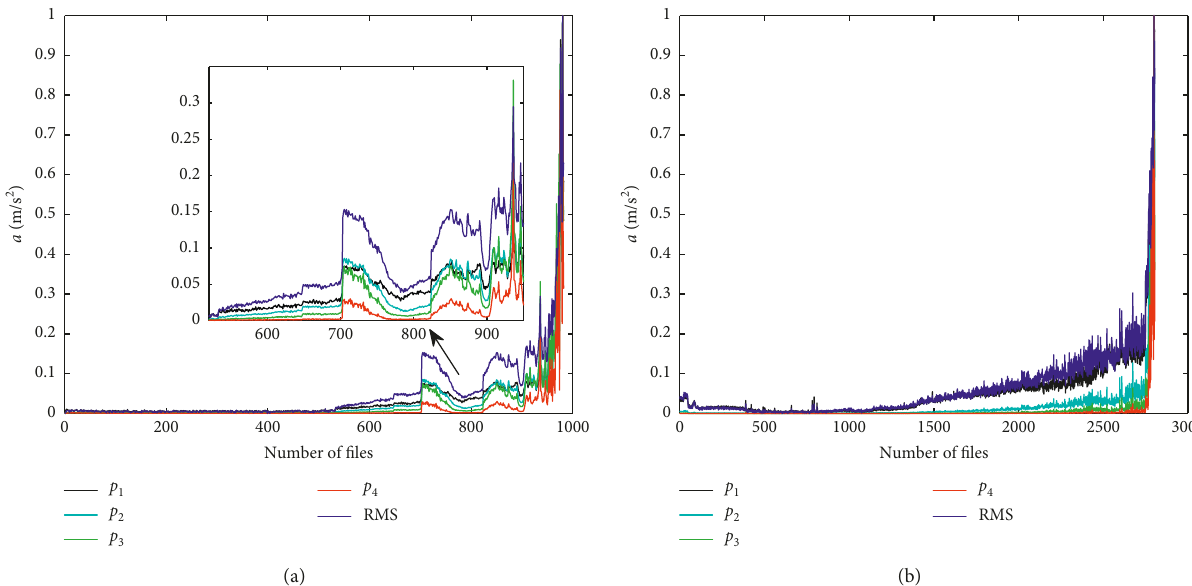
Figure 10: The p 1 , p 2 , p 3 , p 4 , and RMS of the whole life of (a) Case I and (b) Case II compared with RMS (the five features are normalized).